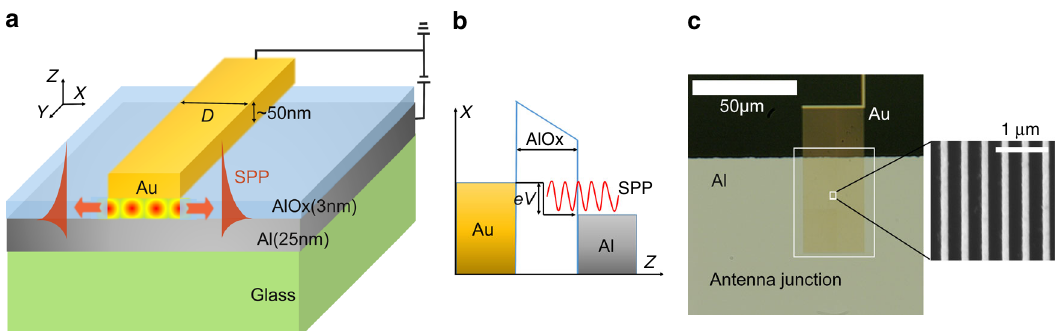
Fig. 1 Principle of antenna surface plasmon emission by inelastic tunneling (ASPEIT). a Schematic of the device consisting of a gold patch antenna (thickness 50 nm and width D ) on an aluminum fi lm (thickness 25 nm) with a 3-nm-thick tunnel barrier of AlO x in between. Gap plasmons propagating along the x -axis under the gold patch are re fl ected at the edges forming a Fabry – Perot cavity. The surface plasmons transmitted at the edges propagate along the Al/air interface. They are observed by leakage radiation microscopy through a fi nite thickness of Al. When applying a voltage bias V , SPPs can be excited by inelastic tunneling. b Energy level diagram for the metal – insulator – metal (MIM) tunnel junction with a voltage bias V . The black arrow shows the maximum electron energy loss, which is the maximum plasmon energy. c Optical microscope image showing the periodical antenna junction (inside the white square). A SEM image shows a zoom of the array of linear antennas (width D = 128 nm, period